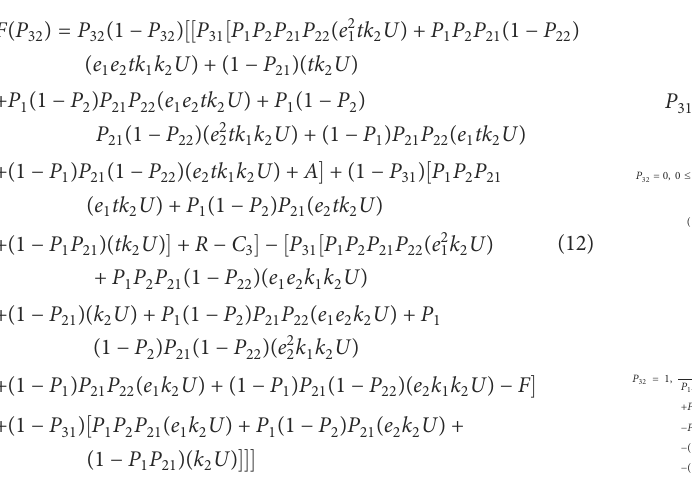
TABLE 7 Eigenvalues of Jacobian matrix J (third stage). Equilibrium